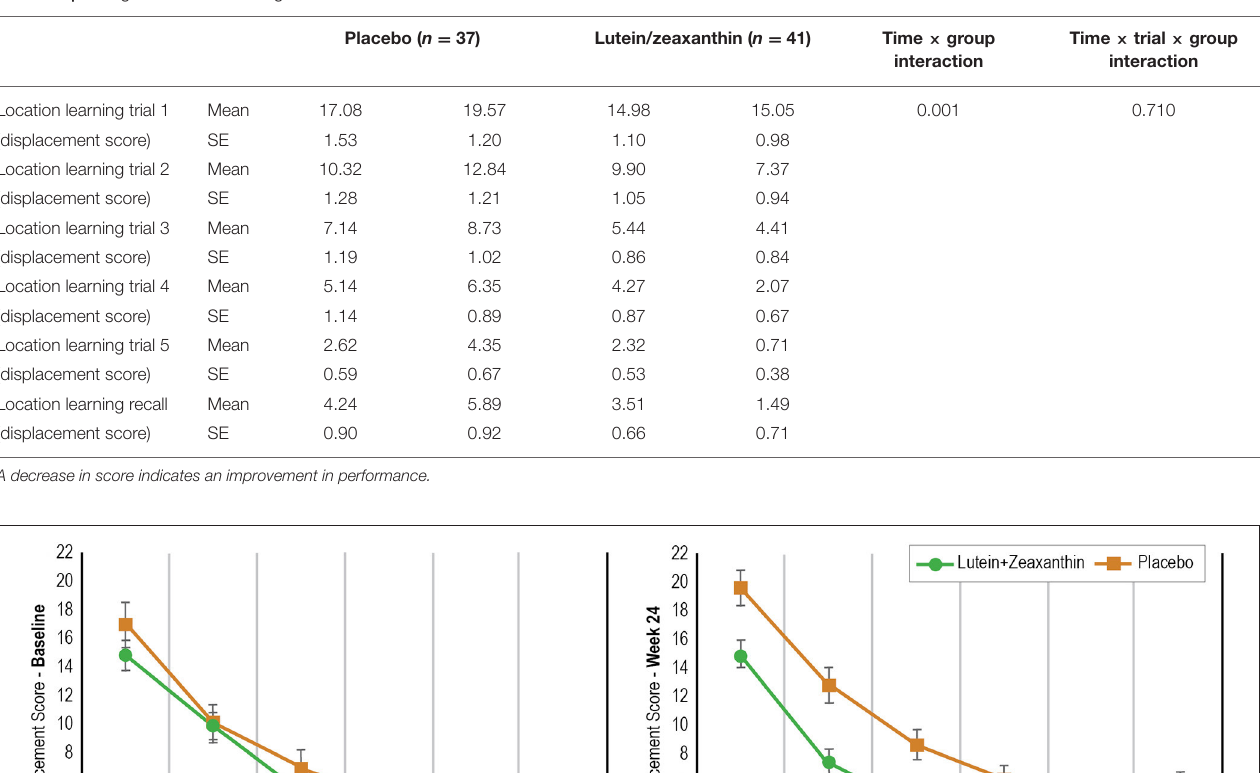
TABLE 5 | Change in location learning scores.